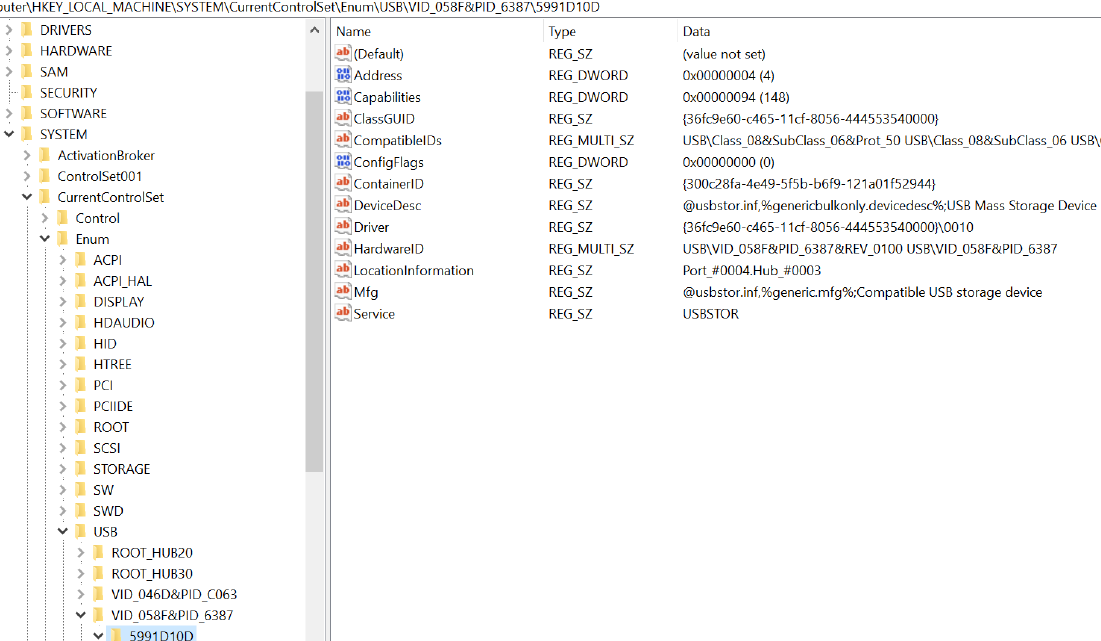
Figure 14. USB Registry key.